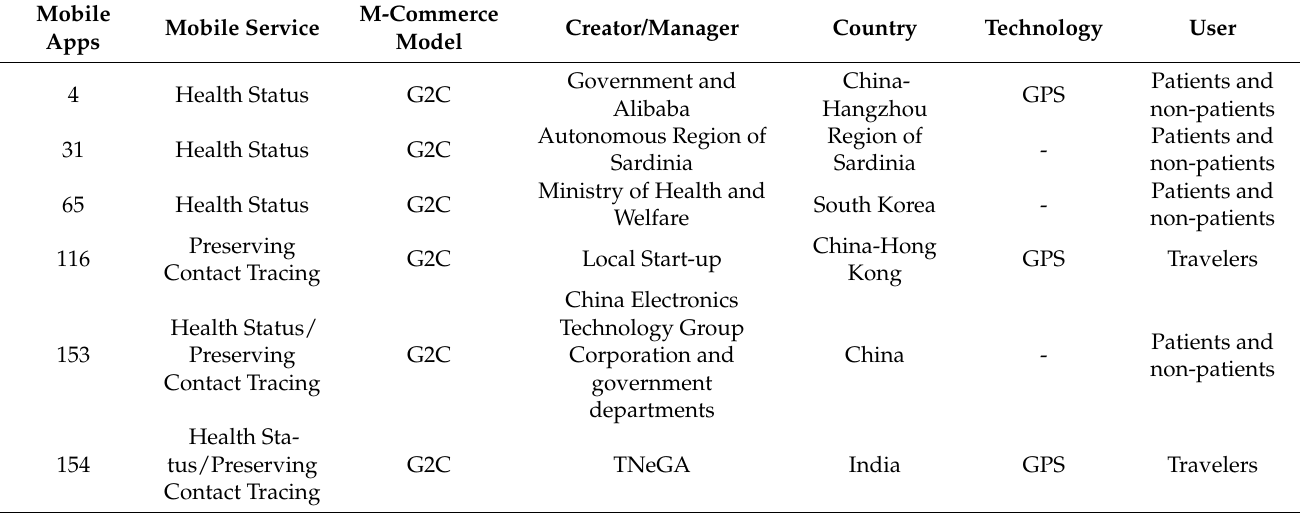
Table 5. Mandatory COVID-19